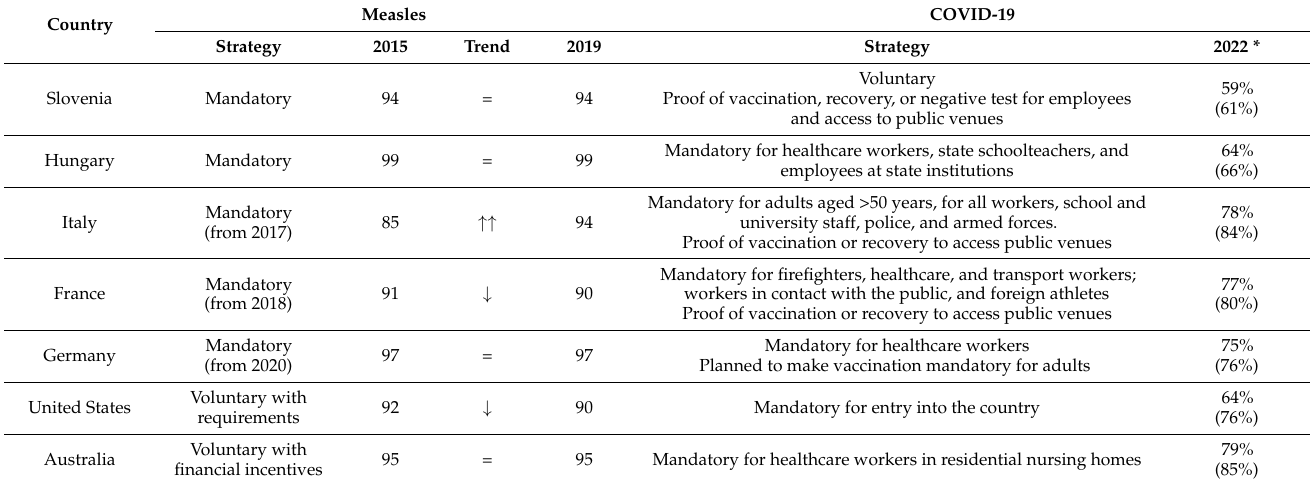
Table 1. Measles and COVID-19 vaccination strategies, and corresponding vaccination coverages